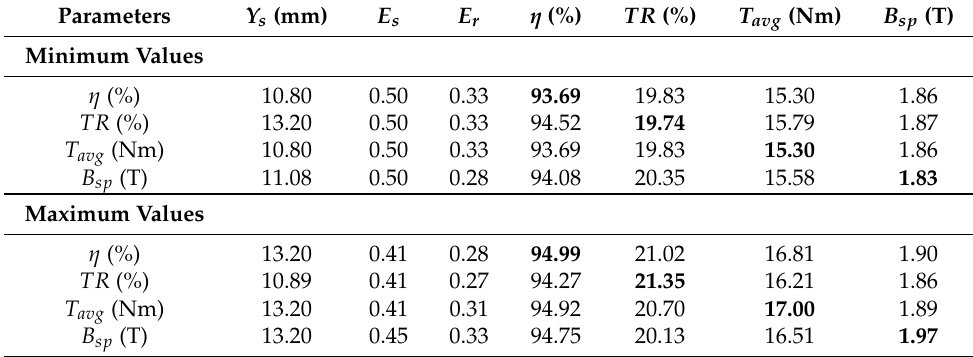
Table 4. Details of Min–Max Search